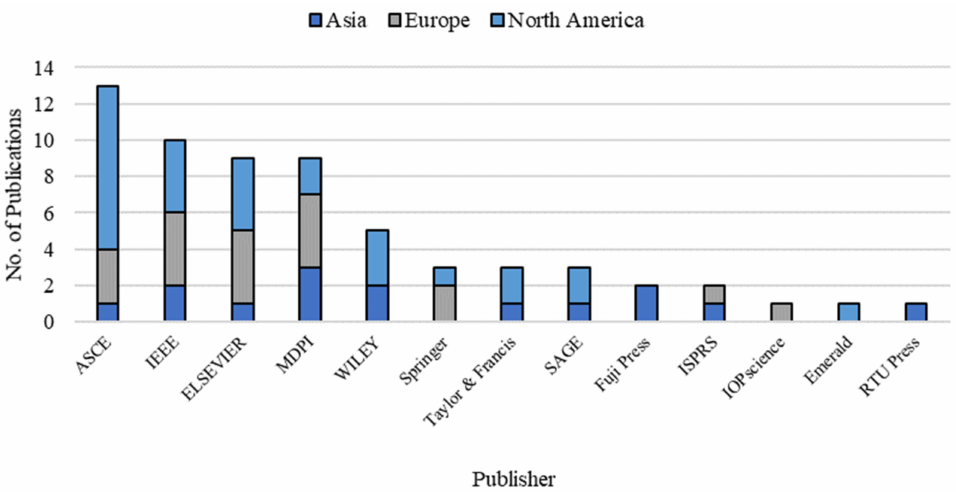
Figure 3. Region-based distribution and publisher count of compiled NDT-UAV studies.